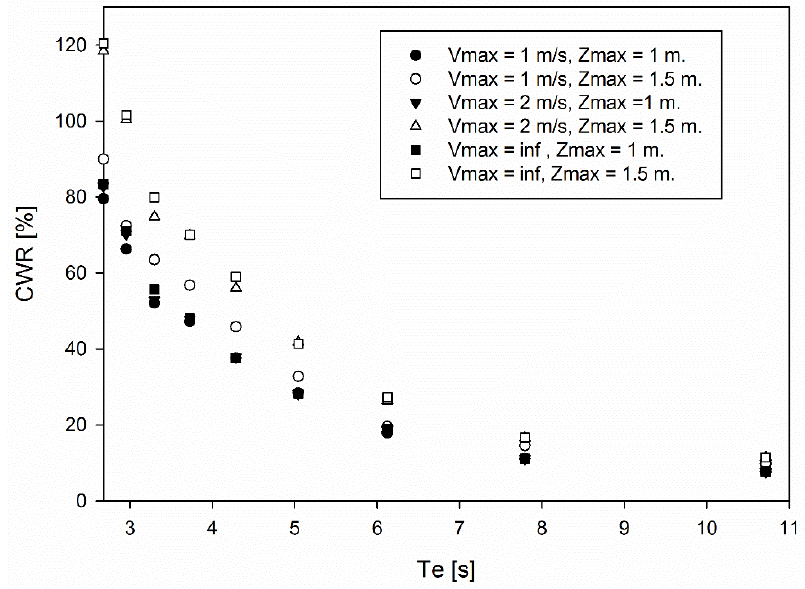
Figure 8. Performance of the WEC under NPC with different constraints. (cid:1834)